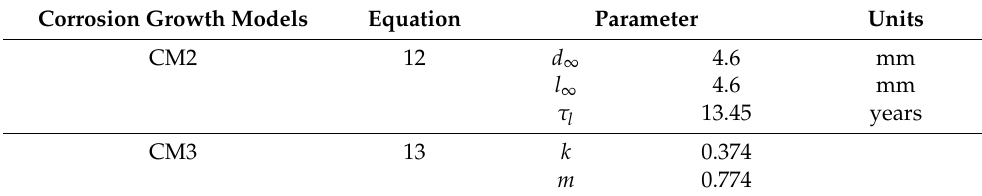
Table 7. Parameters of the different corrosion models. Corrosion Growth